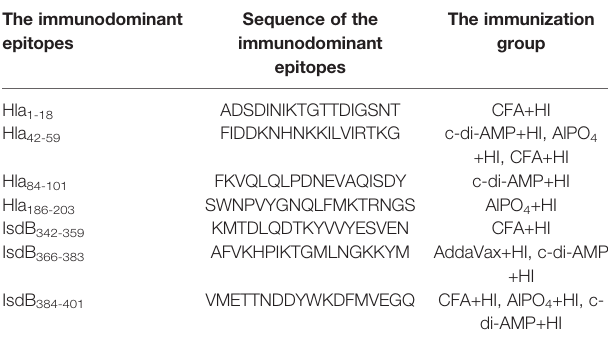
TABLE 1 | Sequence of the immunodominant epitopes on Hla and IsdB identi fi ed in this study. The immunodominant